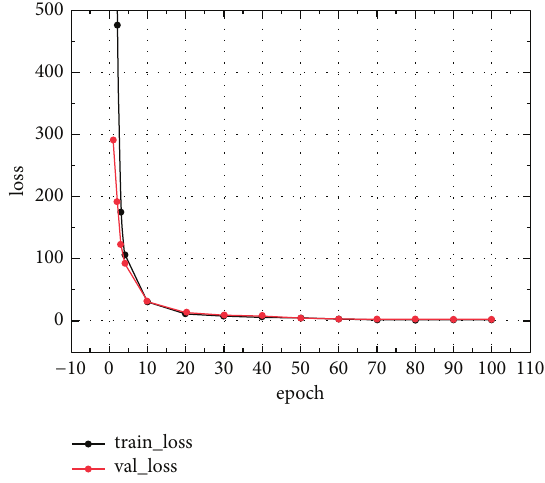
Figure 8: Loss curve during training.